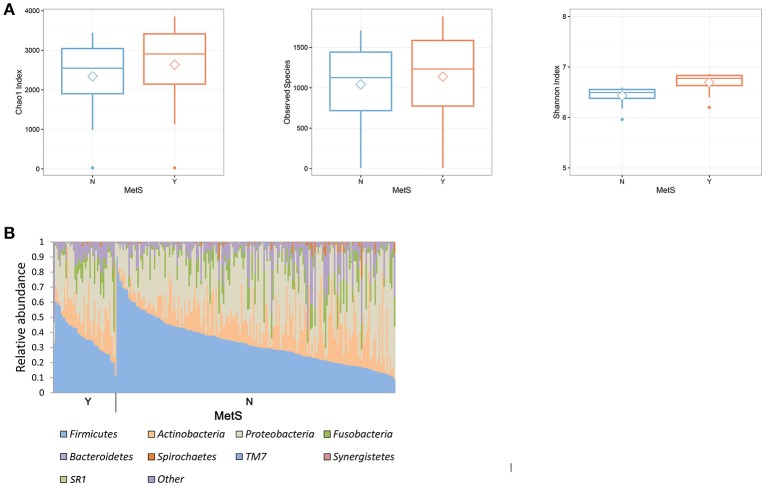
Comparison of microbial composition of oral microbiota in healthy and MetS subjects. (A) Boxplot of α-diversity in the oral microbiome. Boxes represent the 25th percentile, median, and 75th percentile. Whiskers and outliers represent the lowest values and the highest values of the number of OTUs (p < 0.05 for the Wilcoxon rank-sum test). (B) Microbial composition in the oral microbiome. The groups consist of 186 healthy controls and 42 MetS subjects.